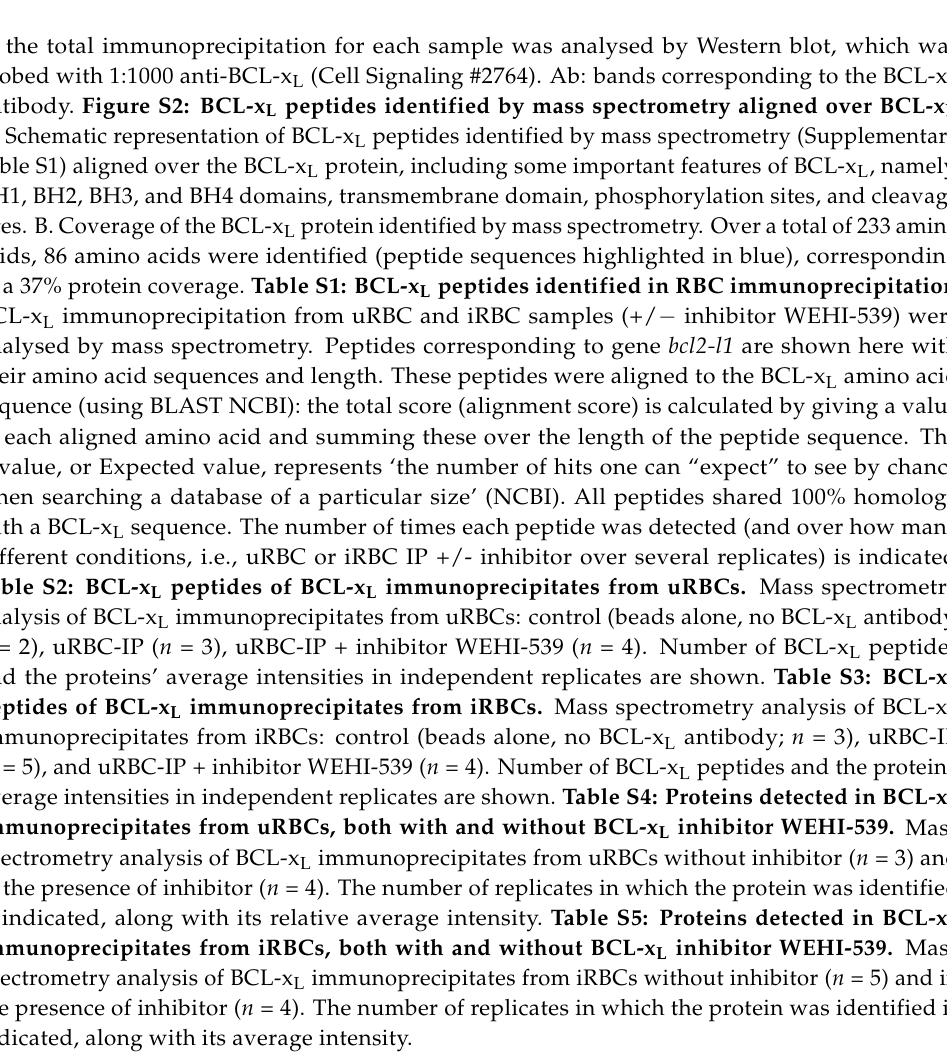
antibody. Figure S2: BCL-x L peptides identified by mass spectrometry aligned over BCL-x L . A. Schematic representation of BCL-x L peptides identified by mass spectrometry (Supplementary